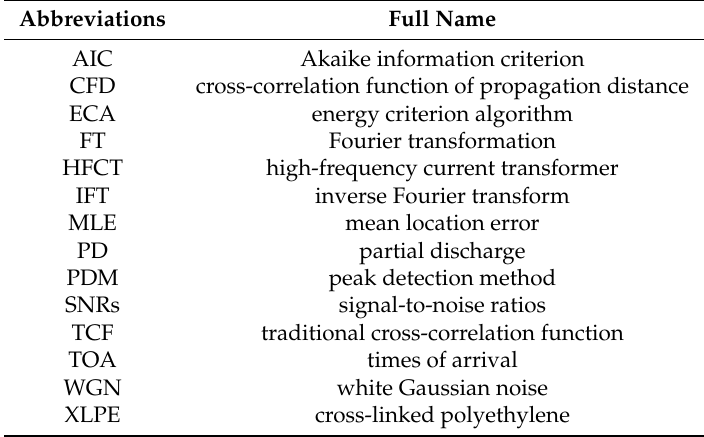
Table A1. List of